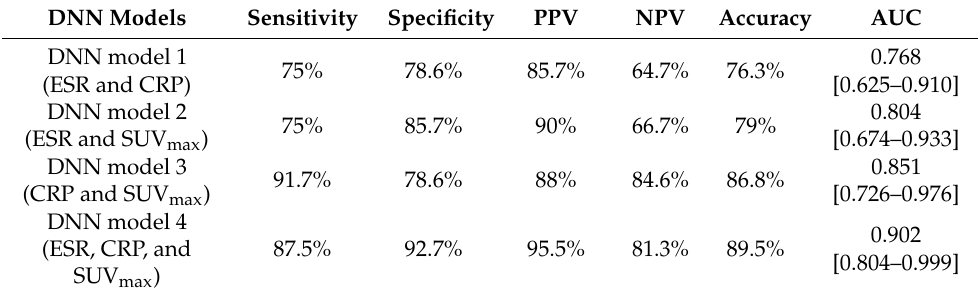
Table 4. Performances of the DNN models for predicting remission in PVO.